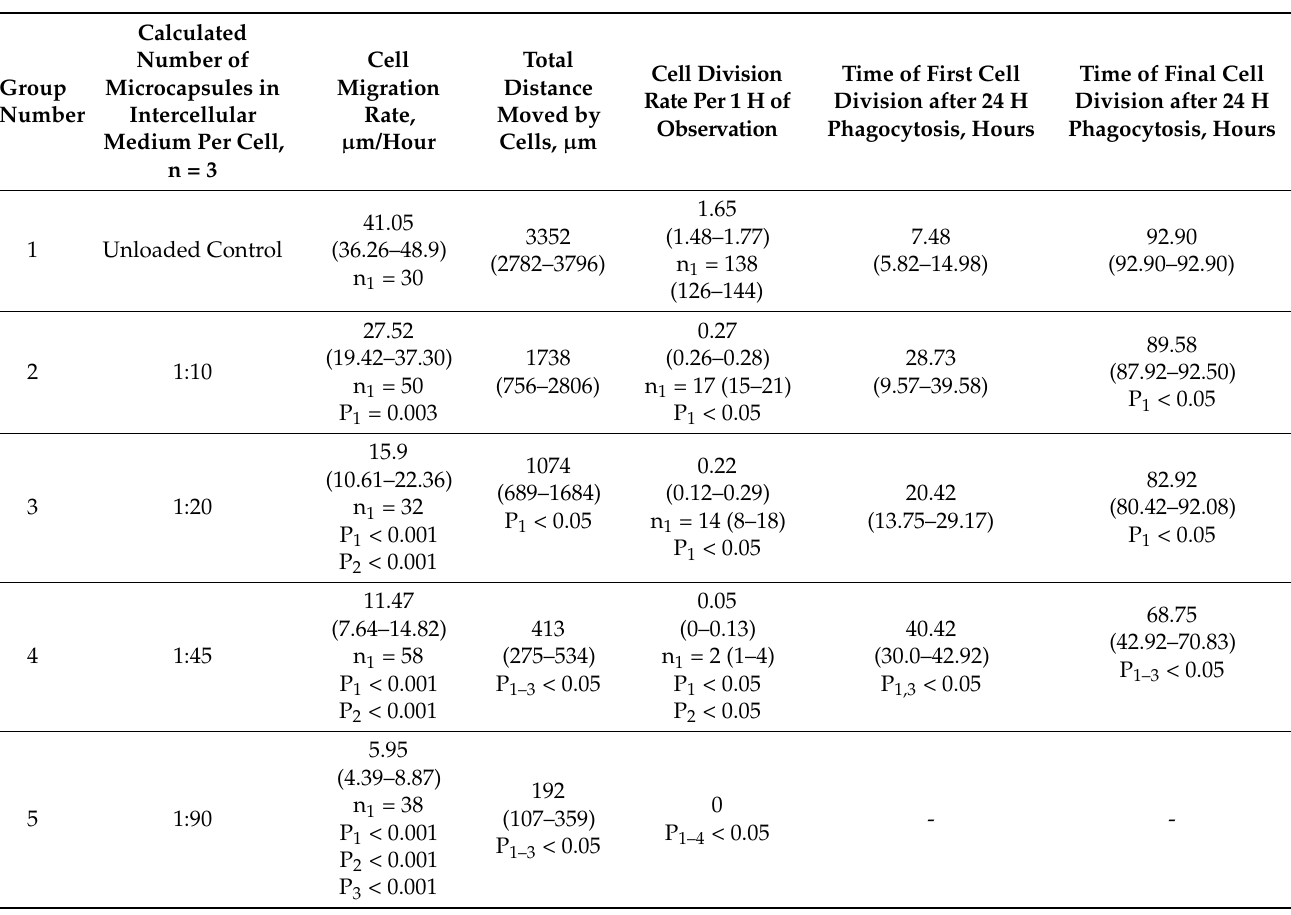
Table 1. Migration activity and division rate of hAMSCs loaded with FITC-labeled microcapsules according to Cell-IQ real-time monitoring, Me